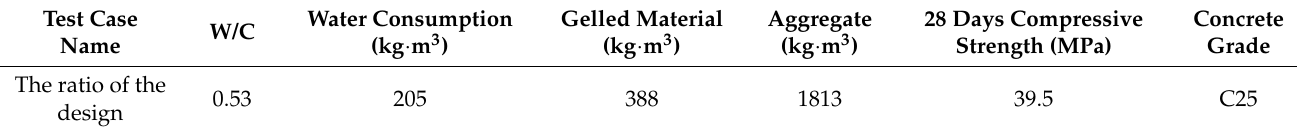
Table 1. Mixed proportion of concrete design of in-service tunnel.